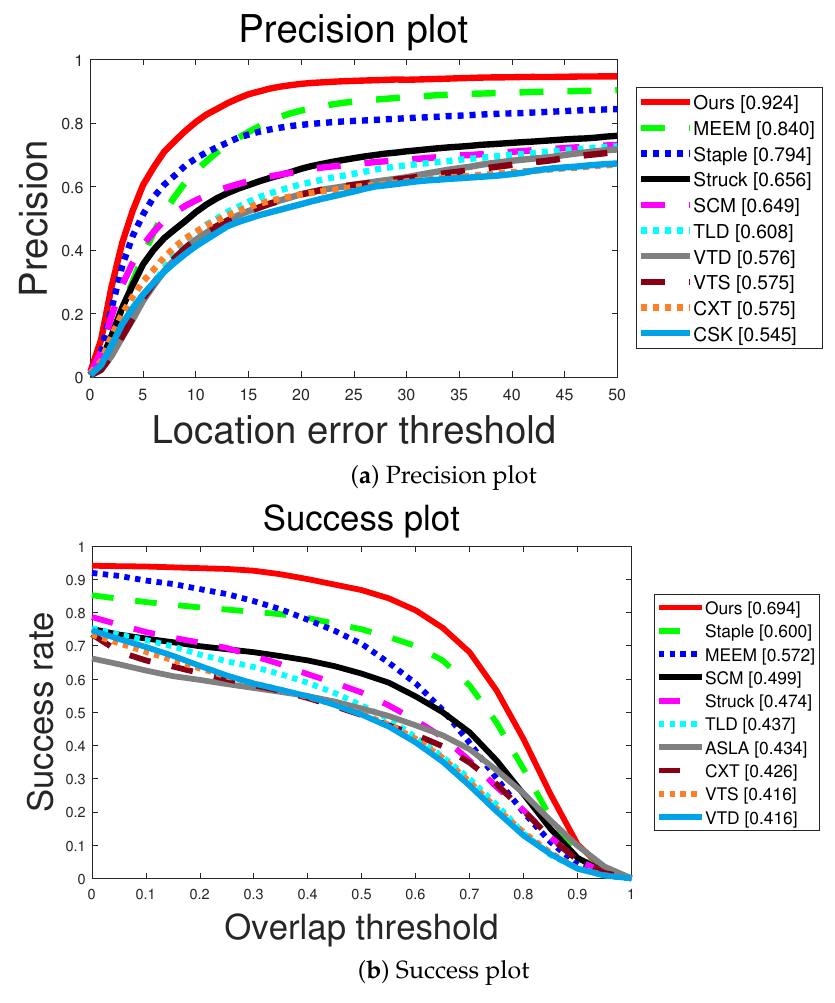
Figure 2. Quantitative comparison with non-deep learning based methods. We evaluate the methods using precision and success plots in ( a , b ),